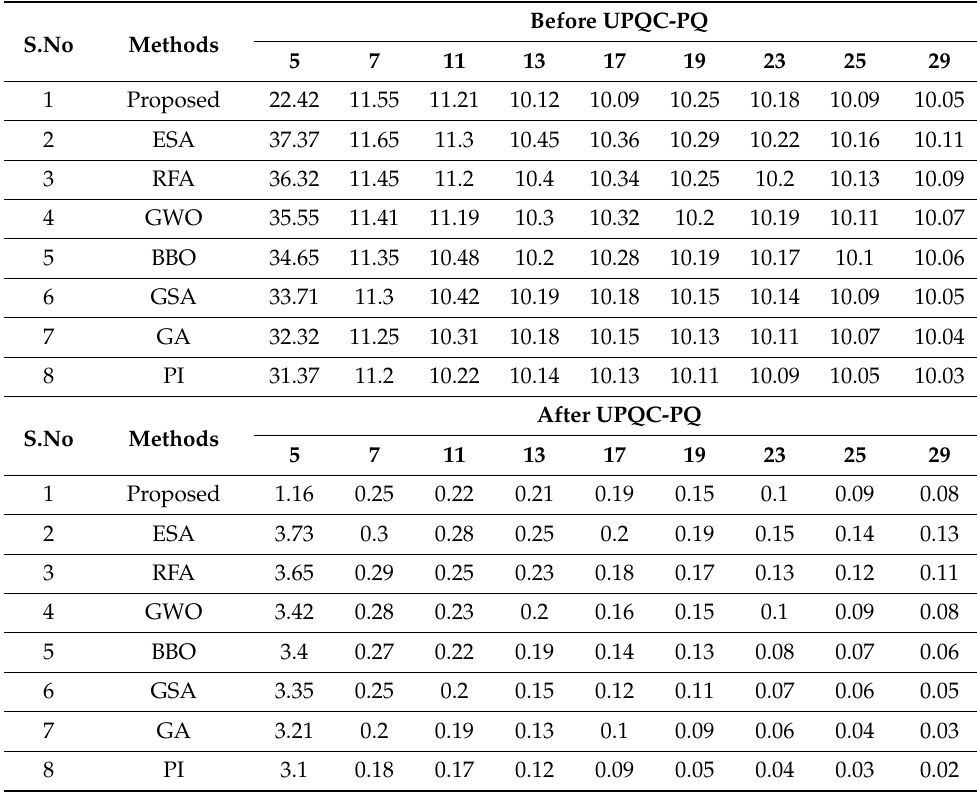
Table 3. THD comparison before and after